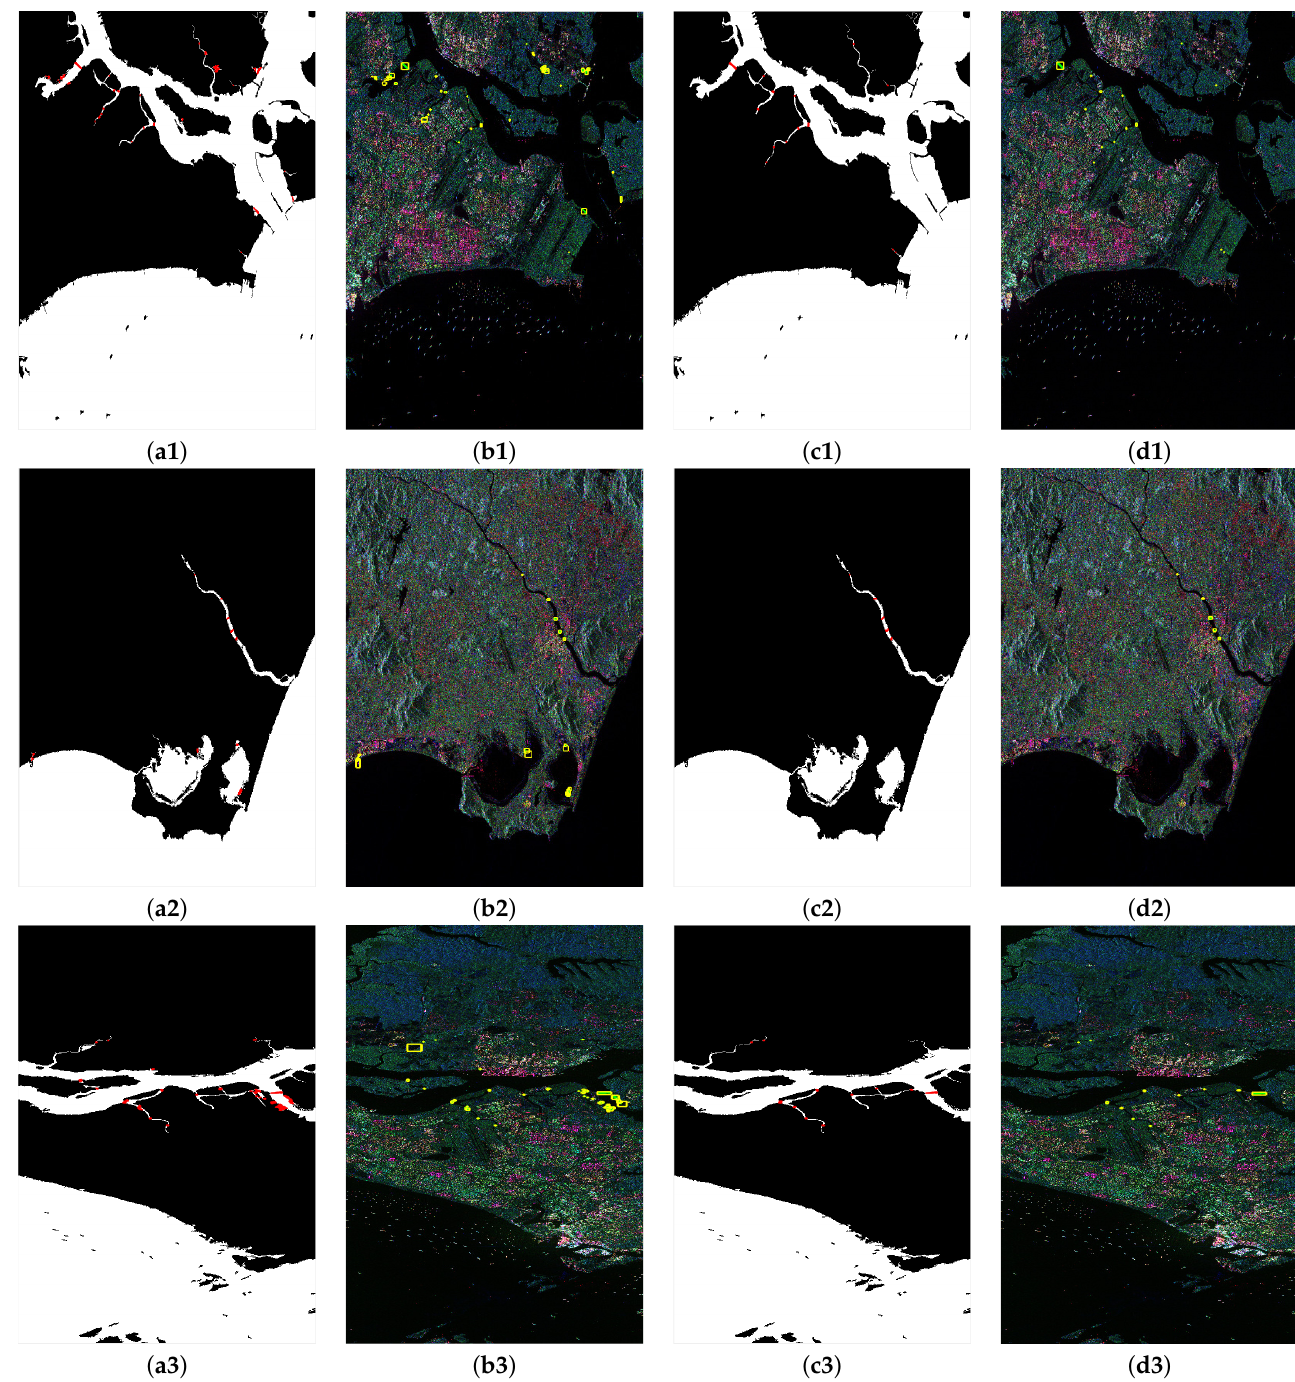
Figure 14. Comparison of the proposed method with the branch merging method: ( a1 – a3 ) the water network connection result of the comparison method, where the detected bridge bodies are marked in red; ( b1 – b3 ) the bridge detection result of the comparison method; ( c1 – c3 ) the water network connection result of the proposed method; ( d1 – d3 ) the bridge detection result of the proposed method; ( a1 – d1 ) results of the data from RADARSAT-2 in Singapore; ( a2 – d2 ) results of the data from RADARSAT-2 in Lingshui; ( a3 – d3 ) results of the data from TerraSAR-X in